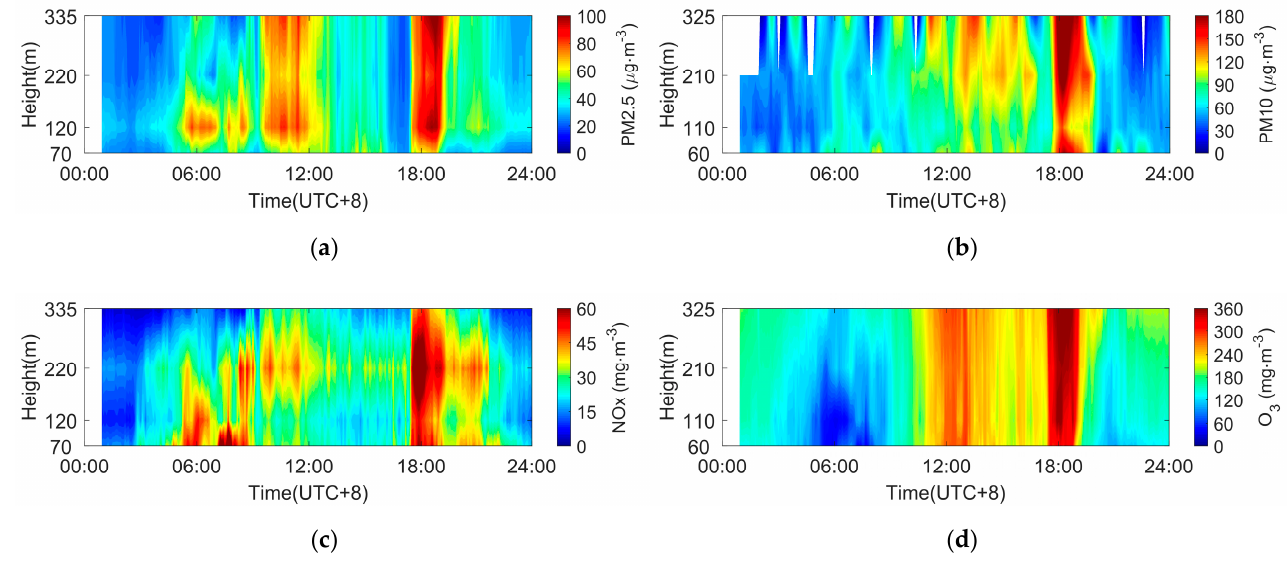
Figure 13. The pollutants concentrations were obtained by sensors on the tower on 25 September 2019. ( a ) PM2.5; ( b ) PM10; ( c ) NO x ; ( d ) O 3 . 2019. ( a ) PM2.5; ( b ) PM10; ( c ) NO x ; ( d ) O 3